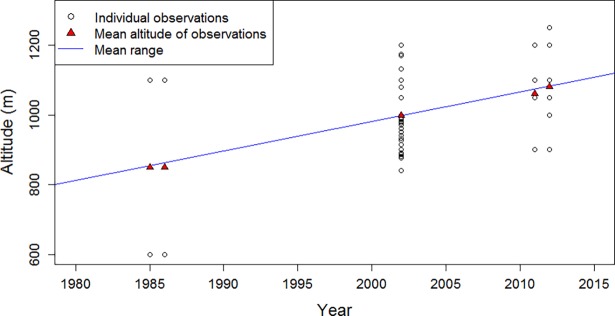
Altitudes of El Oro parakeets.The birds were observed in the years 2002 (998 ± 36 m), 2011 (1061 ± 63 m), and 2012 (1081 ± 23 m). For the years 1985 and 1986, literature values of the distribution range are given (600–1100 m). The El Oro parakeets shifted their range uphill at a rate of 8.5 m per year (depicted by the blue line).